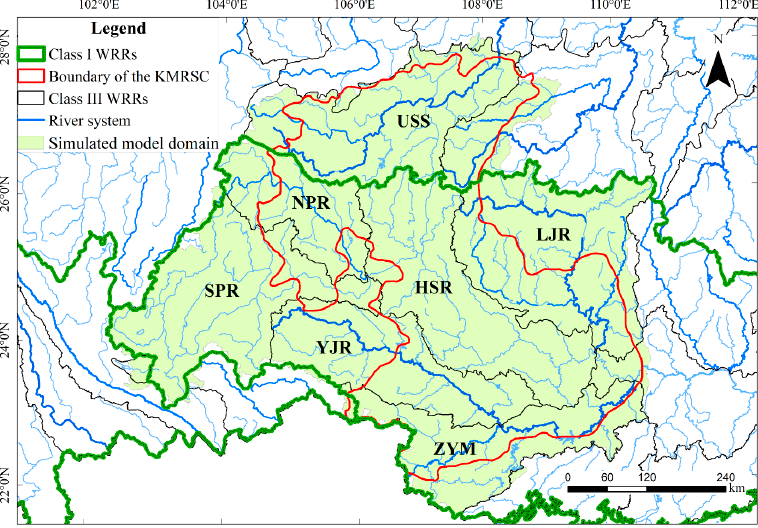
Figure 2. Water resources regions covered in the modelling domain. The modelling domain comprises of seven Class III Water Resources Regions (WRRs), namely, USS (Upstream Sina Station), SPR (South Panjiang River), NPR (North Panjiang River), HSR (HongShuihe River), LJR (LiuJiang River), YJR (YouJiang River), and ZYM (Zuojiang and Yujiang Main Stream).